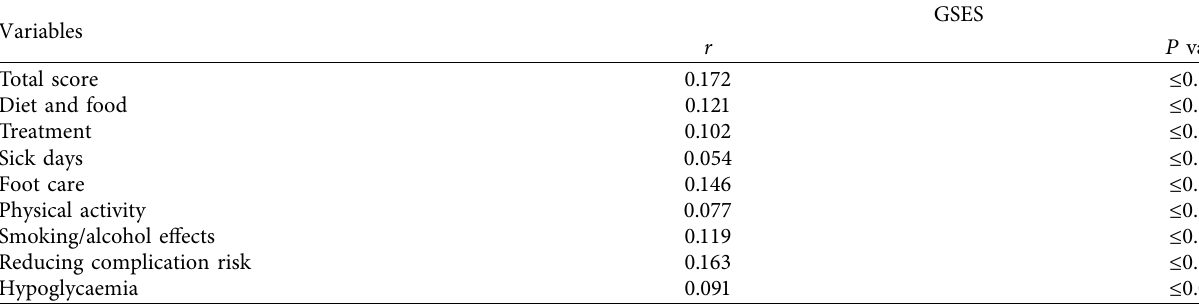
Table 3: Spearman correlation between ADKnowl and GSES.